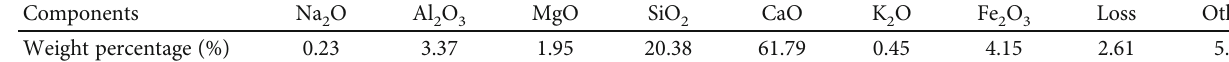
Table 1: XRF analysis of class G Portland cement chemical components.